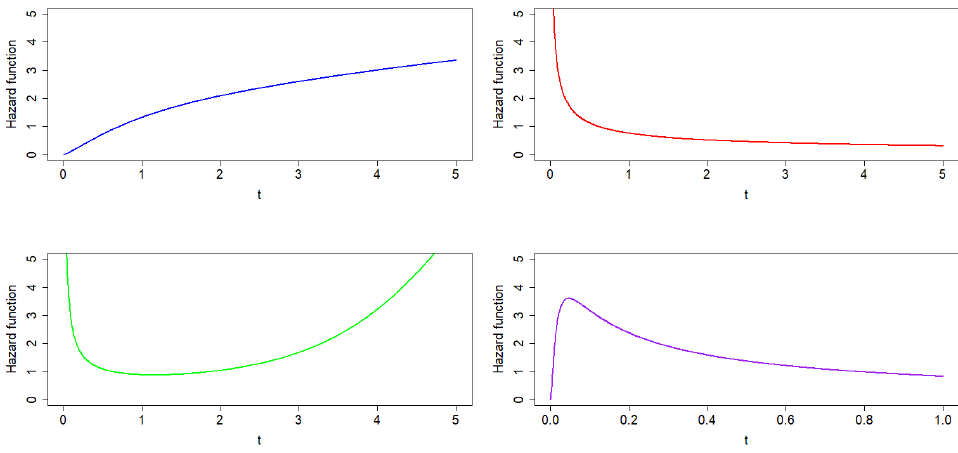
Figure 2. HR shapes for generated distribution for all